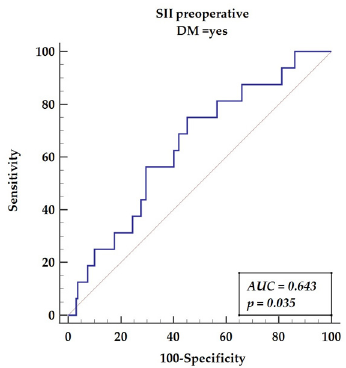
Figure 3. Receiver operating characteristics curve for postoperative SII in DM patients. Abbrevia- tions: AUC—area under the curve, DM—diabetes mellitus, SII—systemic immune-inflammatory index. 3.4. Receiver Operator Curve for Postoperative Inflammatory Markers, including Components of the SII The systemic immune-inflammatory index (SII) is expressed as a quotient of neu- trophils and platelets divided over lymphocyte counts. We present, in Figure 4, compo- nents of the mentioned index comparing its prediction properties, although they were not found to be significant in multivariable analysis.